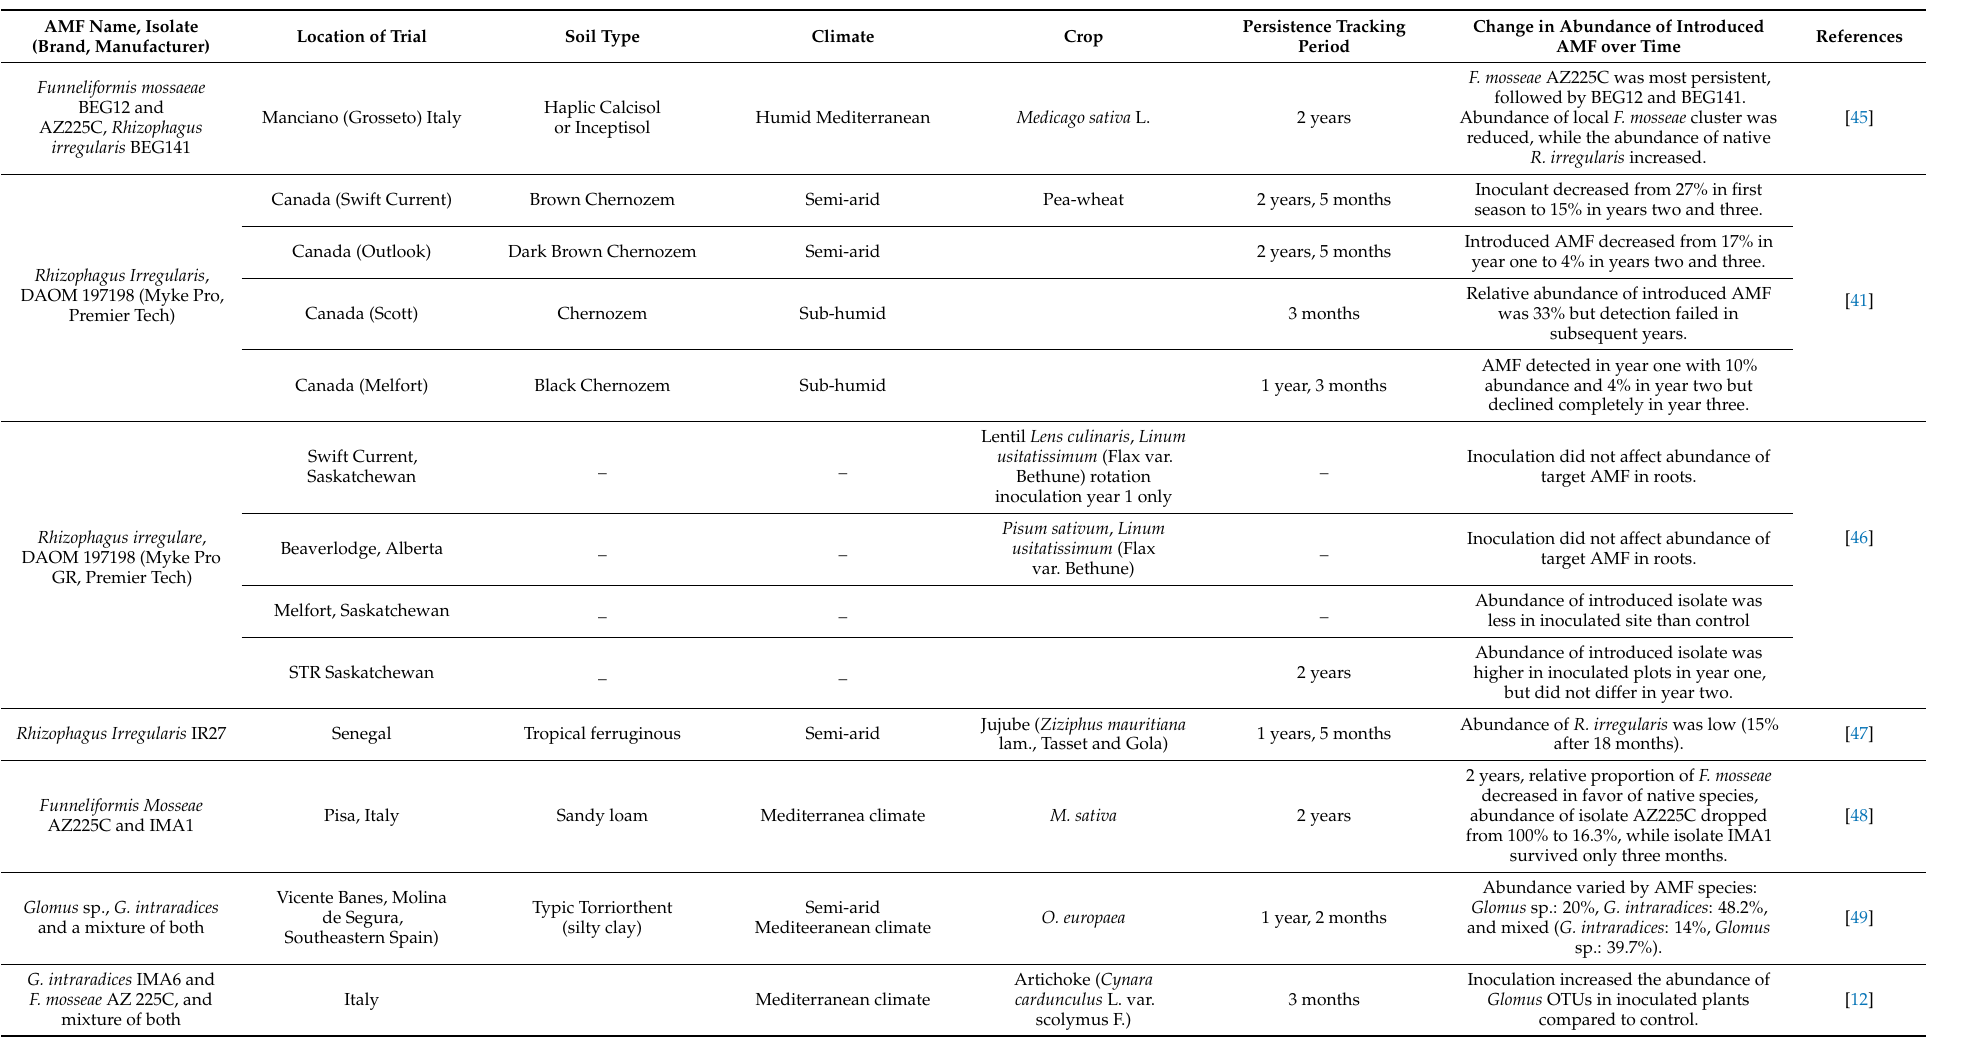
Table 1. Persistence of introduced AMF under field conditions. Criteria for selection are experiment in field and use of molecular tools to trace or monitor introduced